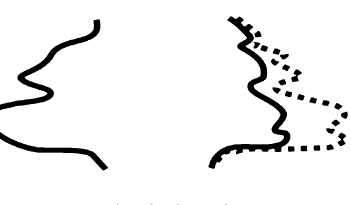
Fig. 2 Curve characteristics of abandoned river